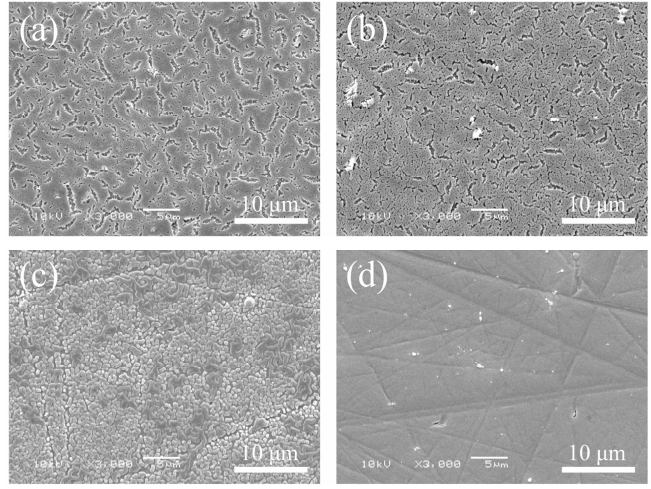
Figure 2. SEM images of the surfaces of ( a ) 600 °C ‐ 2 h, ( b ) 800 °C ‐ 2 h, ( c ) 1000 °C ‐ 2 h, and ( d ) 600 °C ‐ 4 h Y ‐ TZP disks.